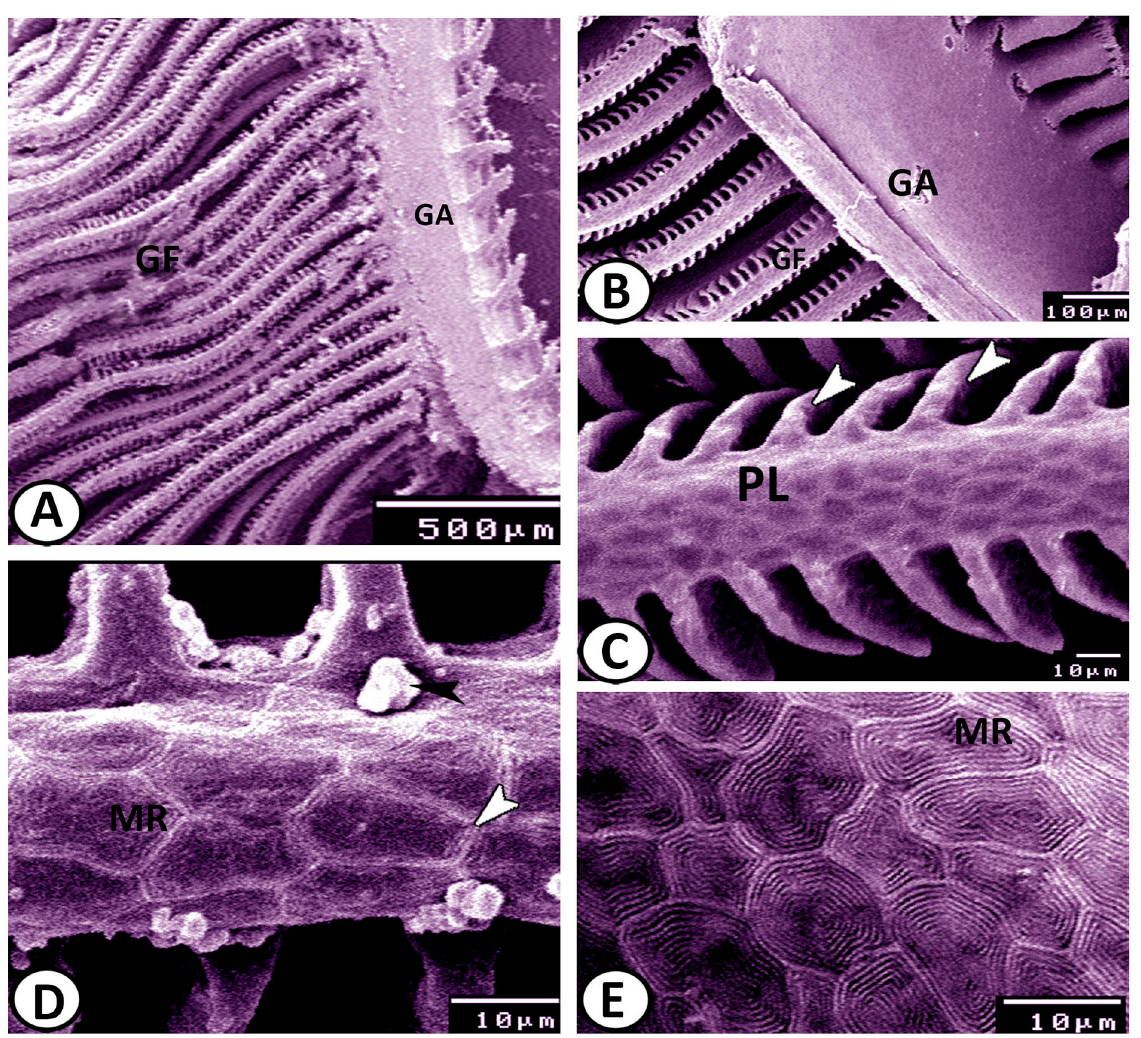
Figure 11. SEM of the gill of molly fish. ( A , B ) The gill arches (GA) radiated many gill filaments (GF). ( C ) The primary gill lamellae (PL) showed many secondary lamellae (arrowheads). ( D , E ) The fingerprint-like microridges (MR) of the apical epithelial PVC cover the gill surface. Note the double ridge marks the borders (white arrowhead) between the neighboring cells. Some mucus secretion (black arrowhead) for the mucous cells could be observed on the surface of the gills.